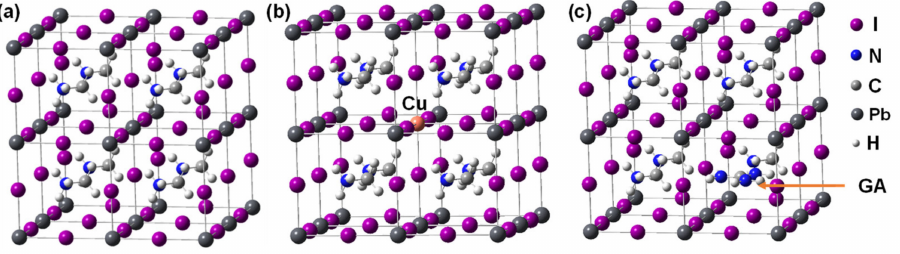
Figure 2. Crystal structures of cubic ( a ) MAPbI 3 , ( b ) MAPb 0.963 Cu 0.037 I 3 , and ( c ) MA 0.875 GA 0.125 PbI 3